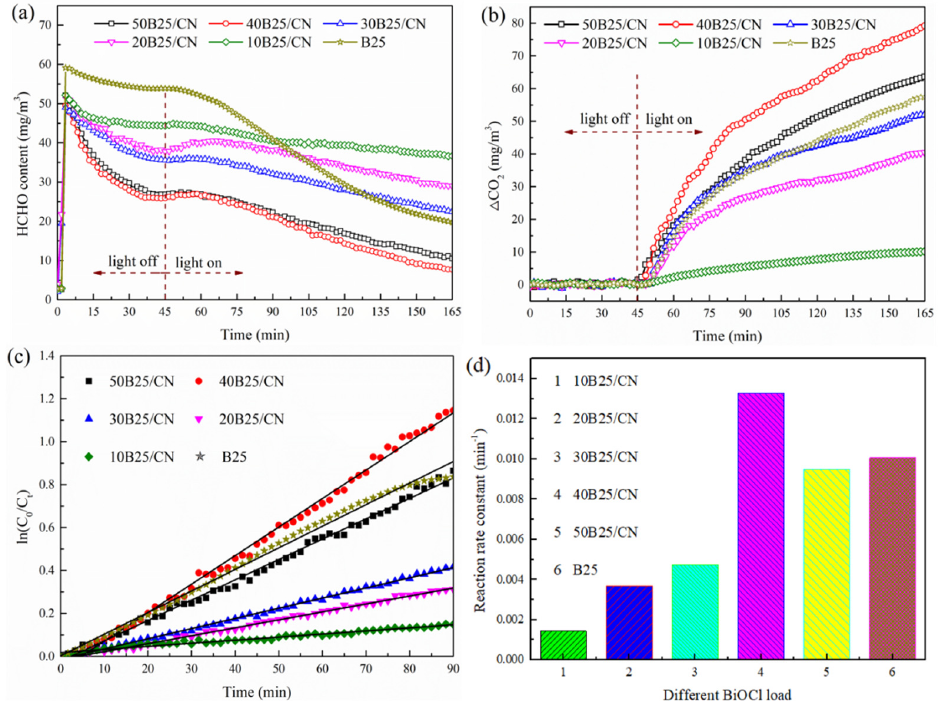
Figure 4. Variations of HCHO concentration ( a ), corresponding increased CO 2 concentration ( △ CO 2 ) ( b ), the kinetic curves ( c ) and the reaction rate constant values ( d ) over different samples under solar light.